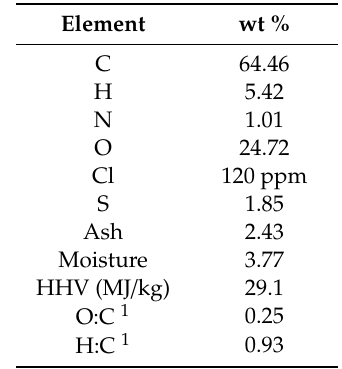
Table 1. Ultimate analysis of lignin (Indulin